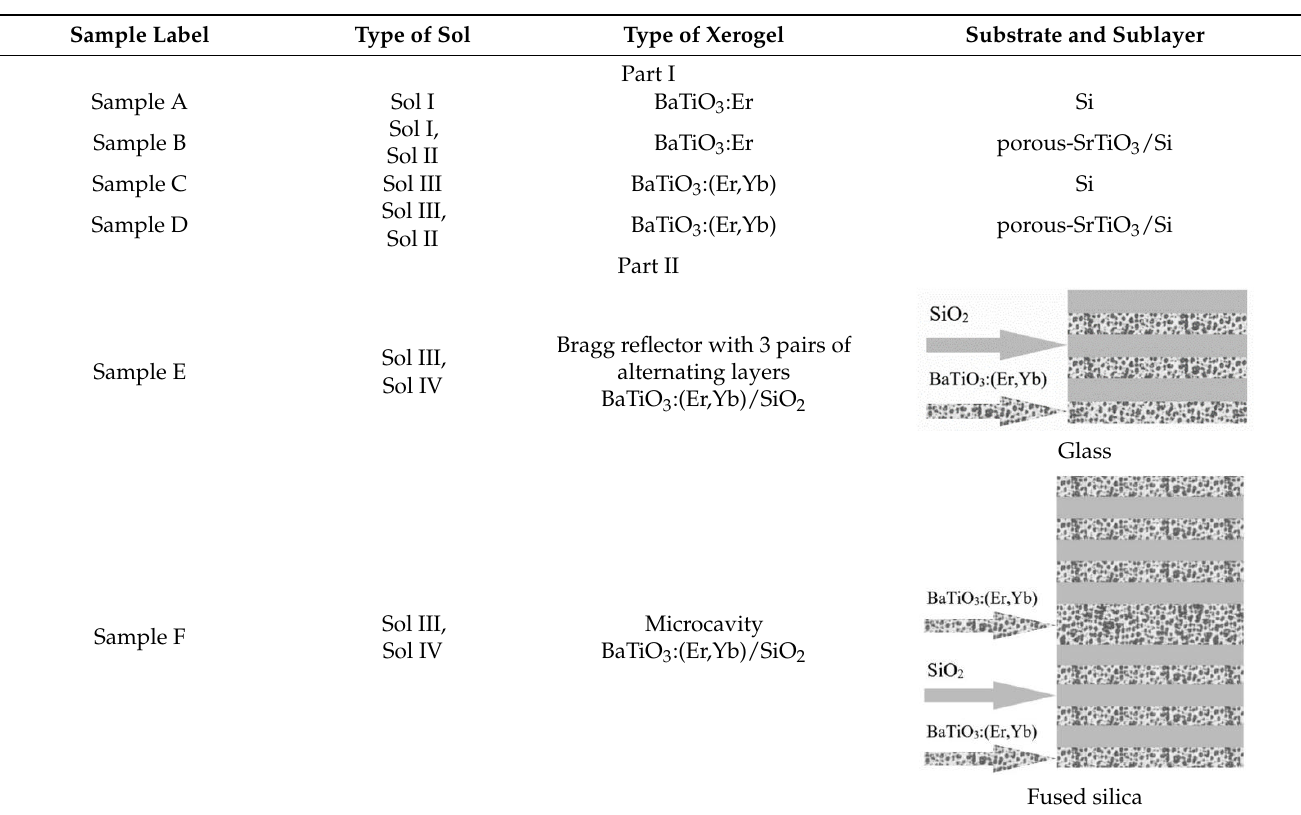
Table 1. Description of the samples under study with BaTiO 3 :Er and BaTiO 3 :(Er,Yb) xerogel films. Sample